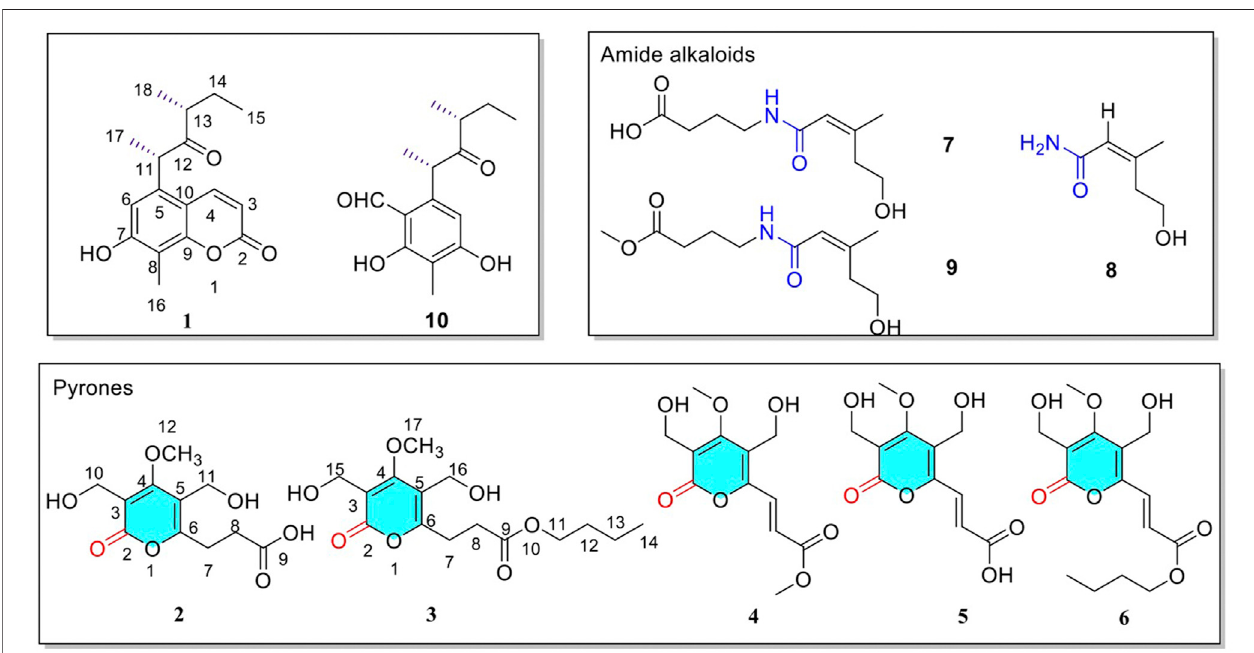
FIGURE 1 | Structure of the identi fi ed compounds 1 –